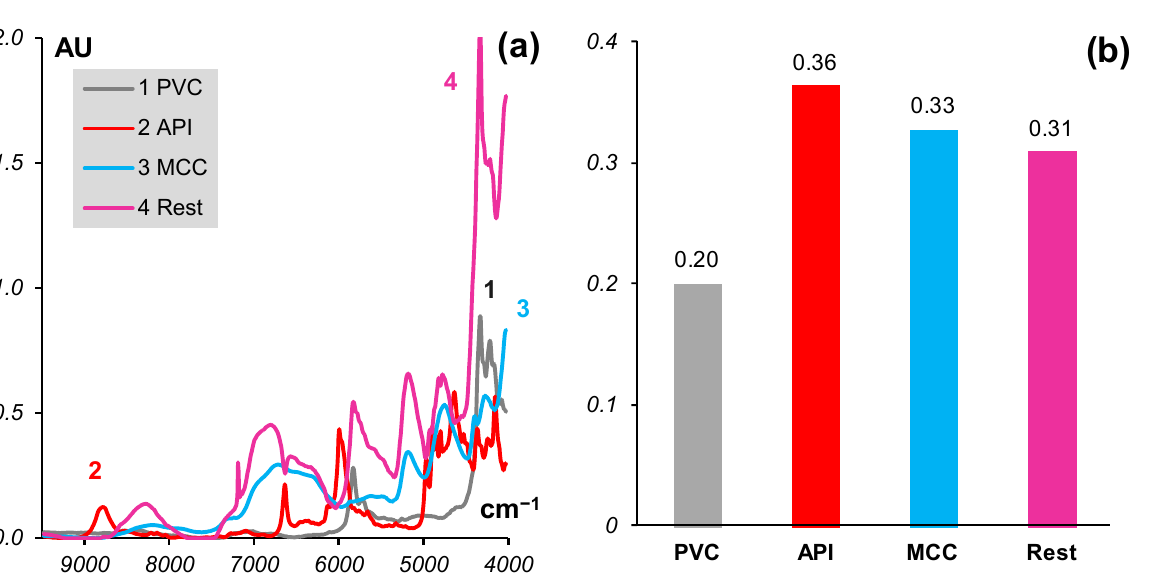
Figure 4. ( a ) Experimental spectrum (1) and its fit by MCR (2); ( b ) Spectrum of Rest and the spectra of some common excipients (vertically shifted). Afterward, we eliminate from the NIR spectra of the tablets, X tab , the part which does not change with time. This fraction includes the spectral data originating from the com- ponents PVC , MCC , and Rest .